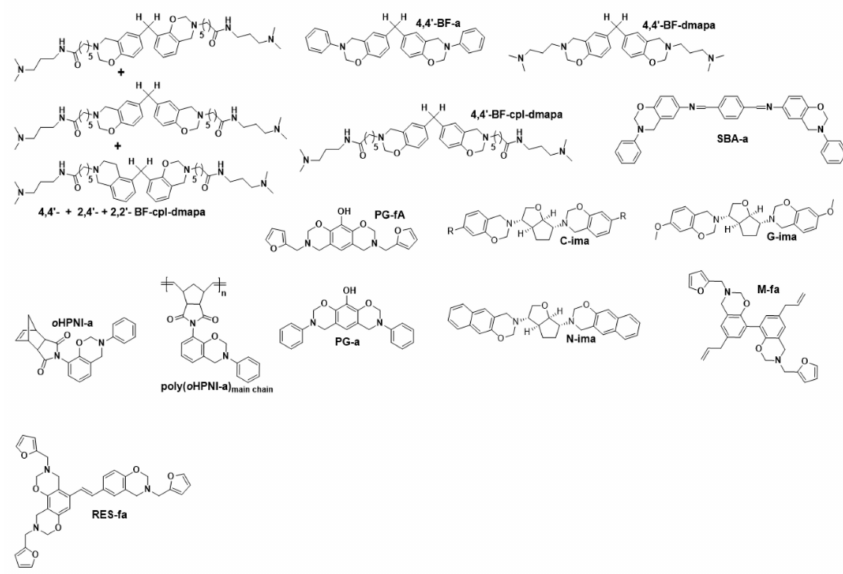
Figure A1. Representative structure of monomers and associated